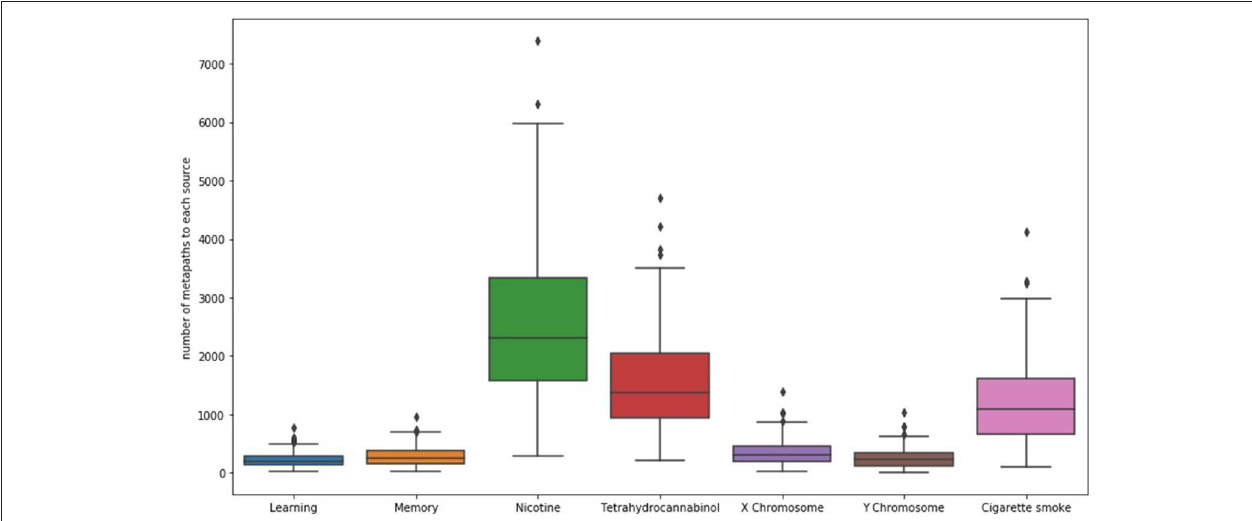
FIGURE 2 | The distribution of the number of unique metapaths between 324 source and 7 target nodes (depicted as bars) for the example SemNet use case, “differential impacts of smoking (cigarette smoke or tetrahydrocannabinol) in men and women.” Nicotine generally had the most diverse connections to the source nodes in this case. The figure shows that number of metapaths varies significantly depending on the target node of interest. Specific and well-known chemicals and biological entities are generally the most highly